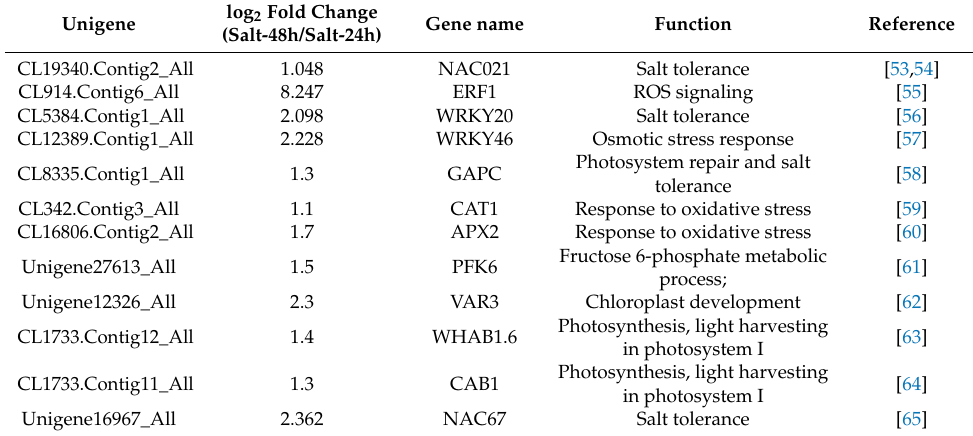
Figure 6. DEGs quantity chart. The X-axis represents each set of differential alignment schemes, and the Y-axis represents the corresponding number of DEGs. Blue represents the number of upregulated DEGs and red represents downregulated DEGs. Table 6. Some of the selected salt-responsive and photosynthesis-related genes that were upregulated at 48 h of salt treatment compared to 24